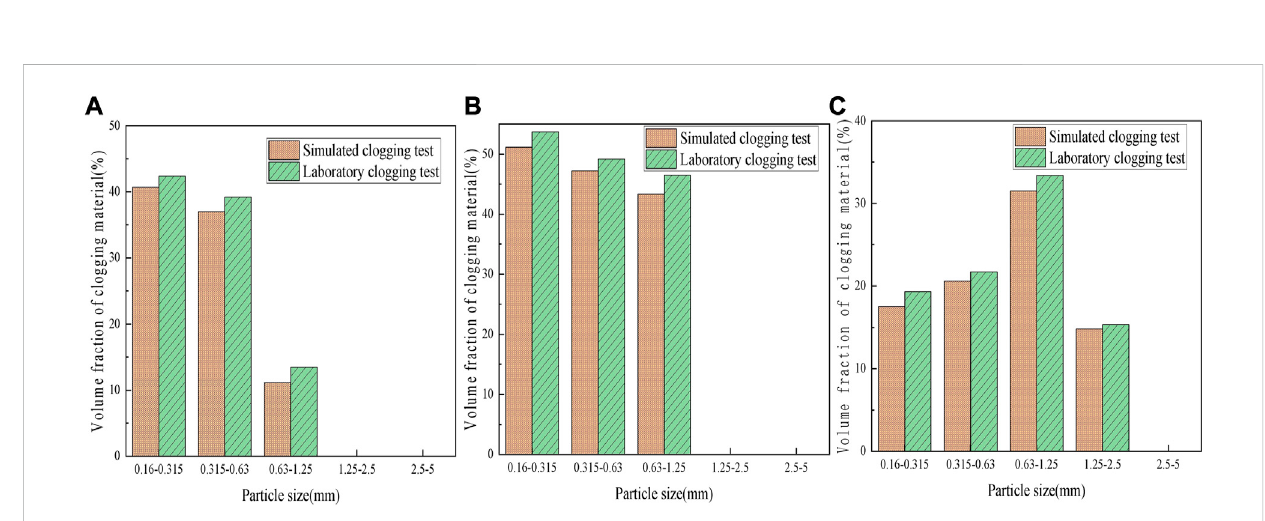
FIGURE 11 Comparison of clogging experiment results between laboratory and numerical simulation. (A) P A1 ; (B) P A2 ; (C) P A3